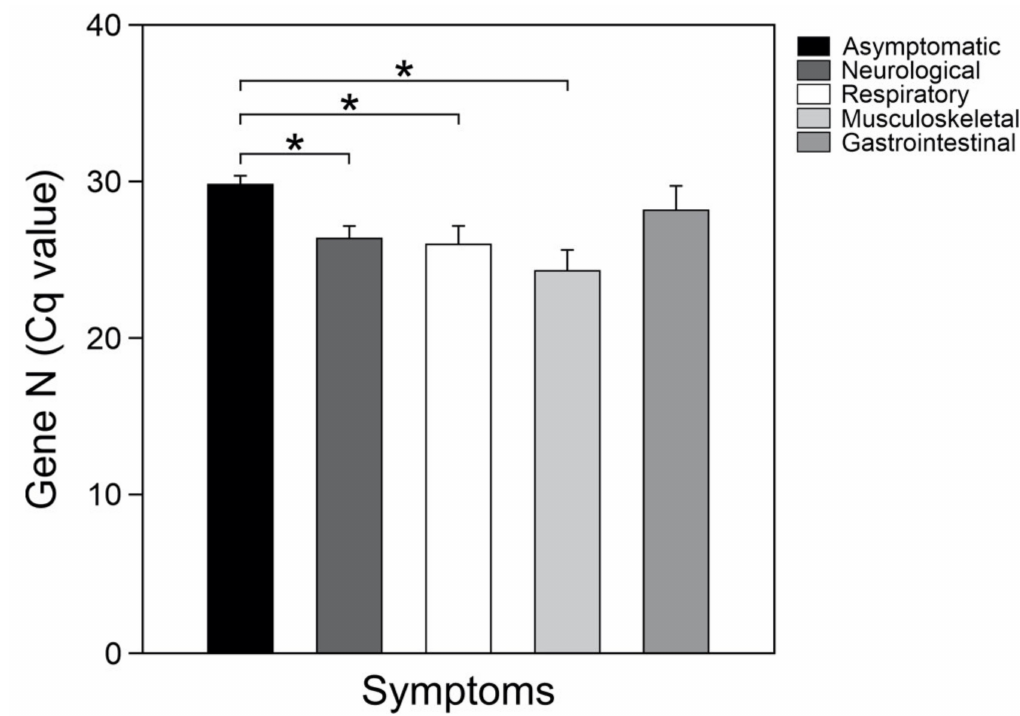
Figure 3. Values of Cq of SARS-CoV-2 positive patients classified by a group of COVID-19-related symptoms. * p <